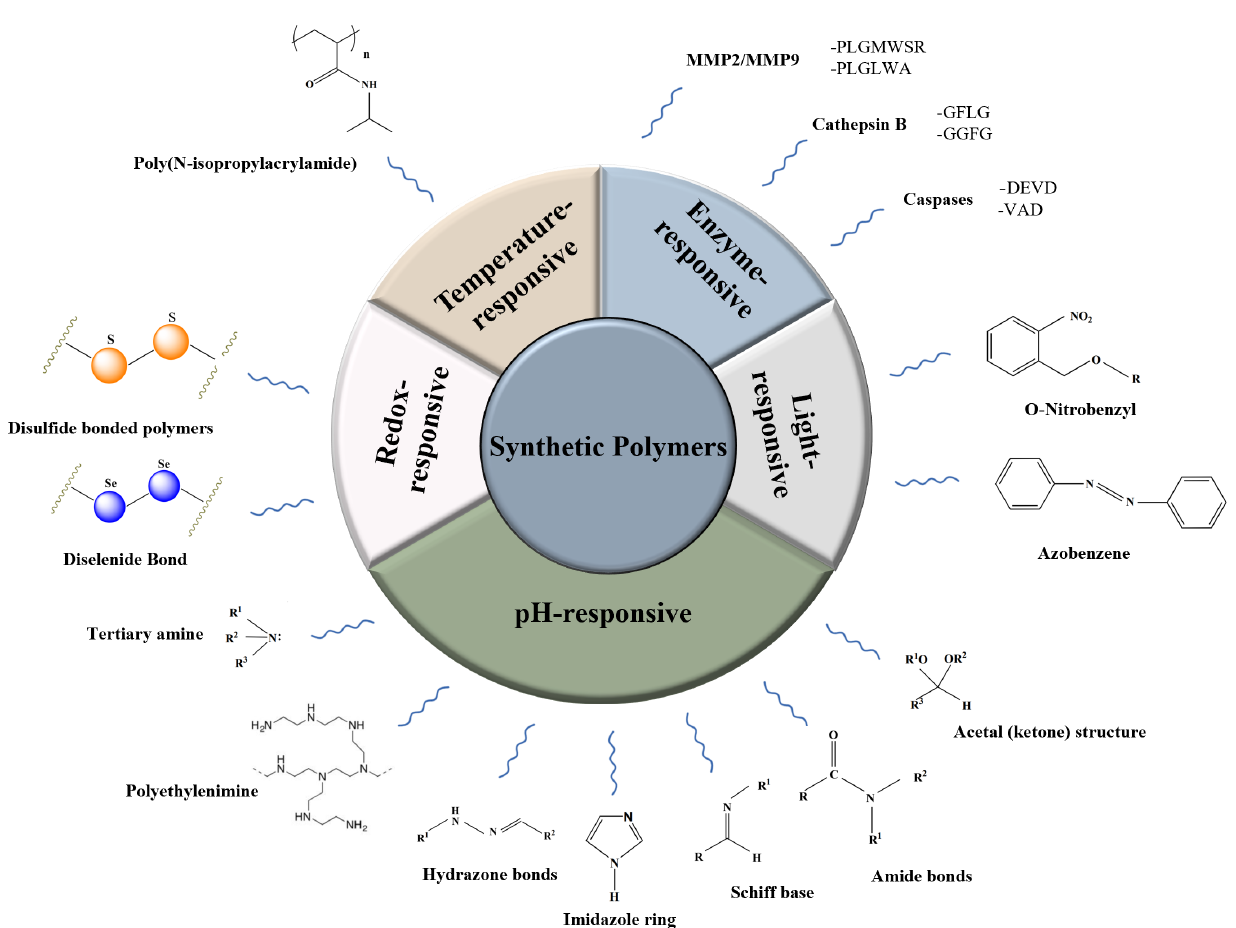
Figure 1. Schematic representation of the stimuli-responsive synthetic polymers.